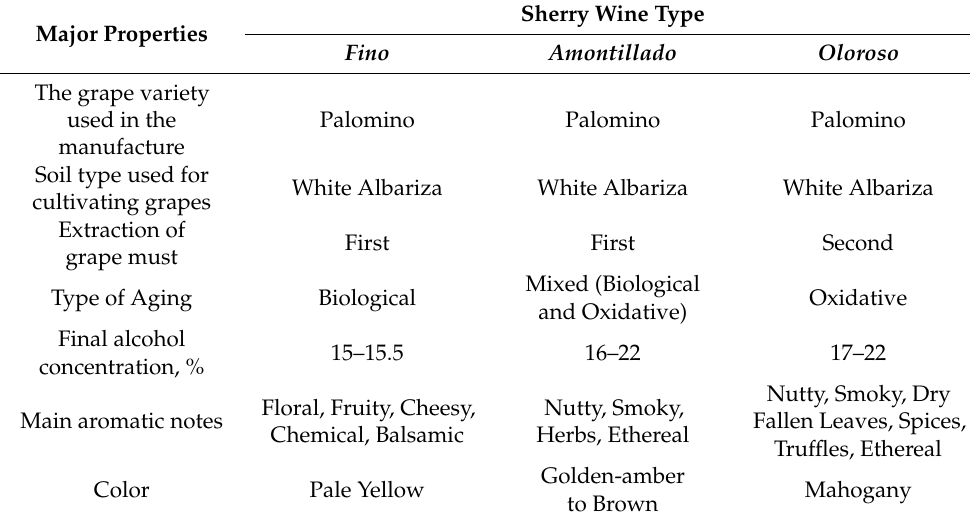
Table 2. Major properties of dry sherry